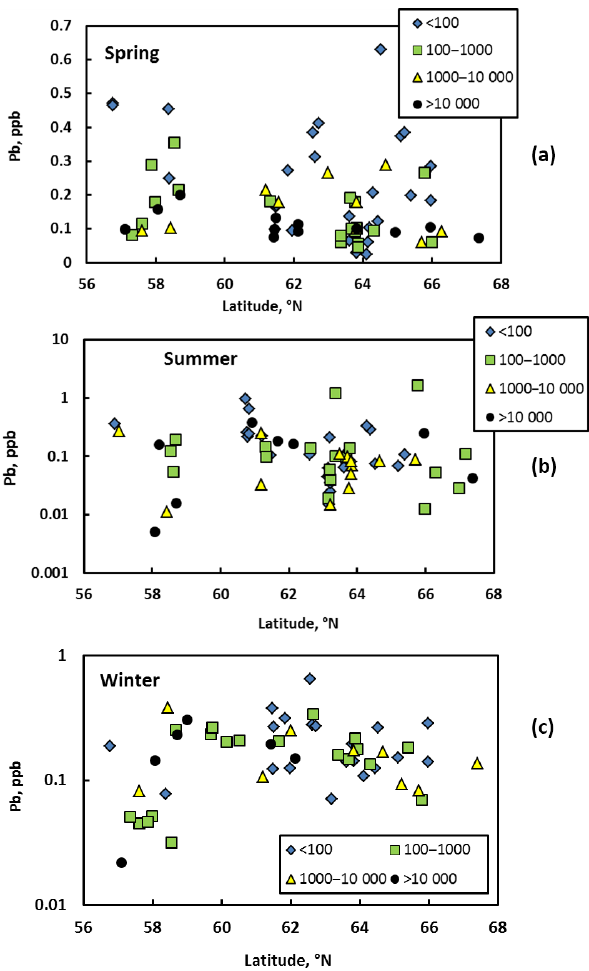
Figure 7. The variation of Pb concentration with latitude during spring (a) , summer (b) and winter (c) for watersheds of different size. The symbols are the same as in Fig. 2.